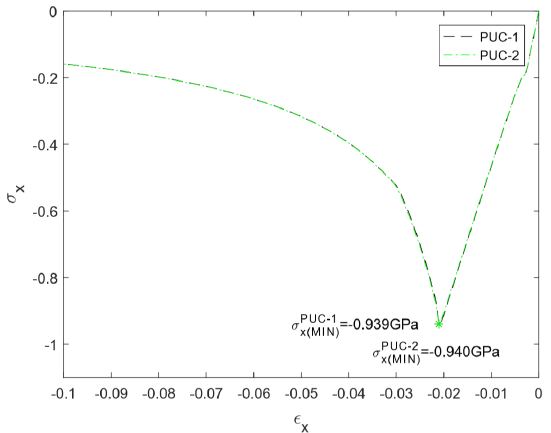
Figure 6. Stress-strain curves for on-axis tensile loading in the x-direction.